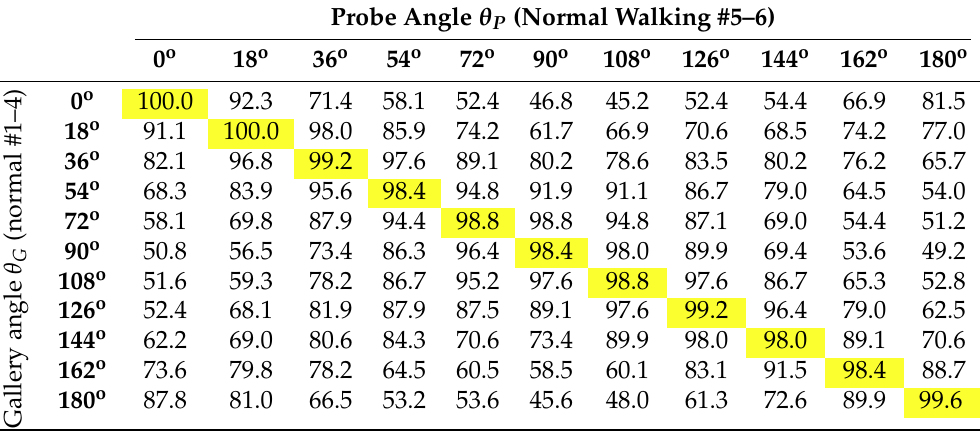
Table 3. Evaluation results, as presented in [15], but using